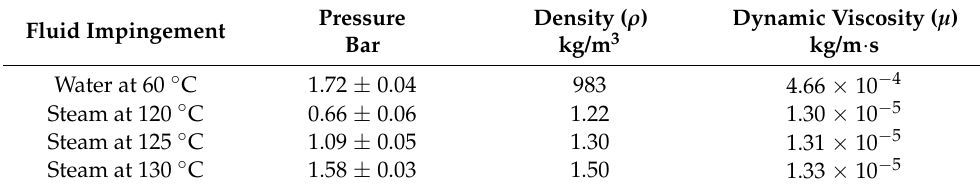
Table 1. Density and dynamic viscosity of water and